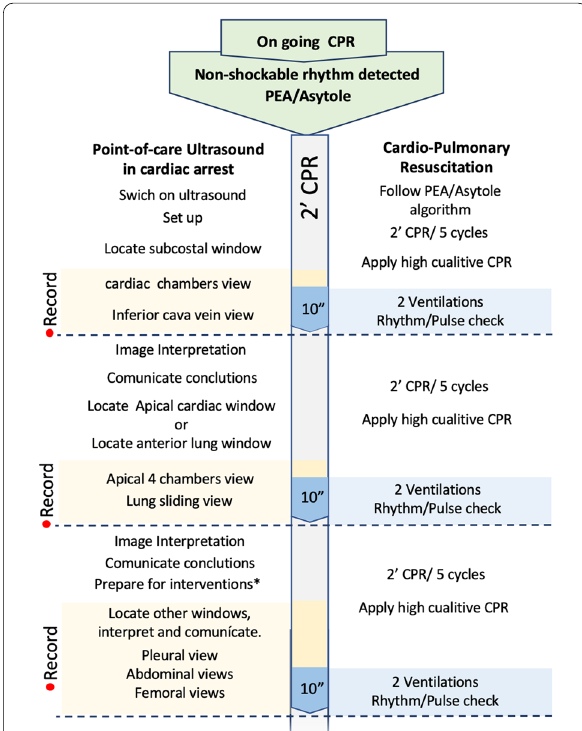
Fig. 1 POCUS‑CA Flowchart. *Echo‑guided pericardiocentesis or thoracostomy.CPR: cardiopulmonary resuscitation, PEA: pulseless electrical